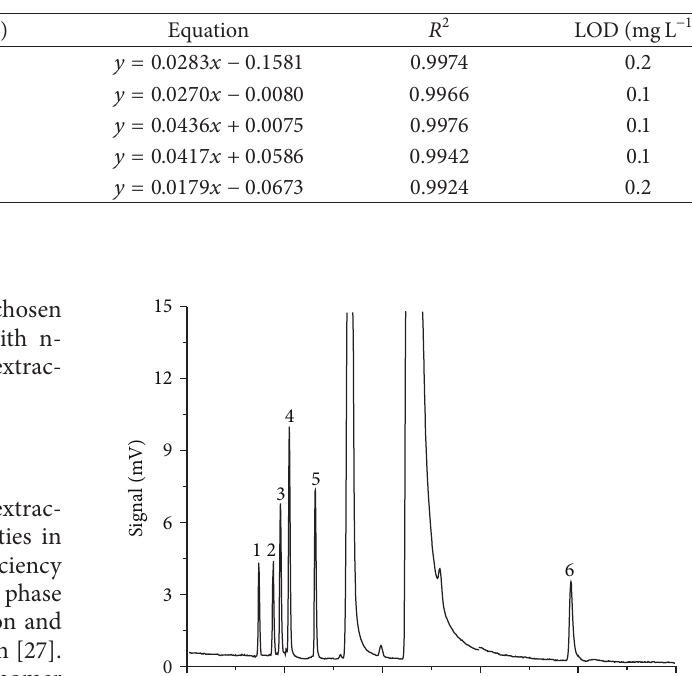
Figure3:Typicalchromatogramwithdifferentheatingratesof(a)constanttemperatureand(b)10 ∘ C ⋅ min −1 .Peaks:solvent(s),dimethylamine ( 1 ), allyldimethylamine ( 2 ), allyl chloride ( 3 ), allyl aldehyde ( 4 ), and allyl alcohol ( 5 ). Table 2: Calibration curve and LODs for allyl chloride and its derivatives.